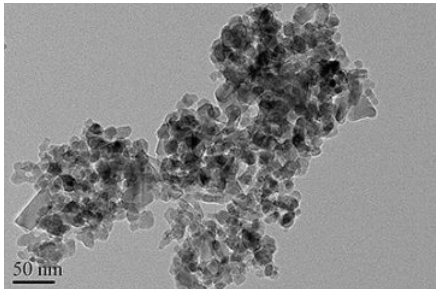
Figure 4. Type 2 nanosilica [manufacturer’s materials, www.us-nano.com (accessed on 14 March